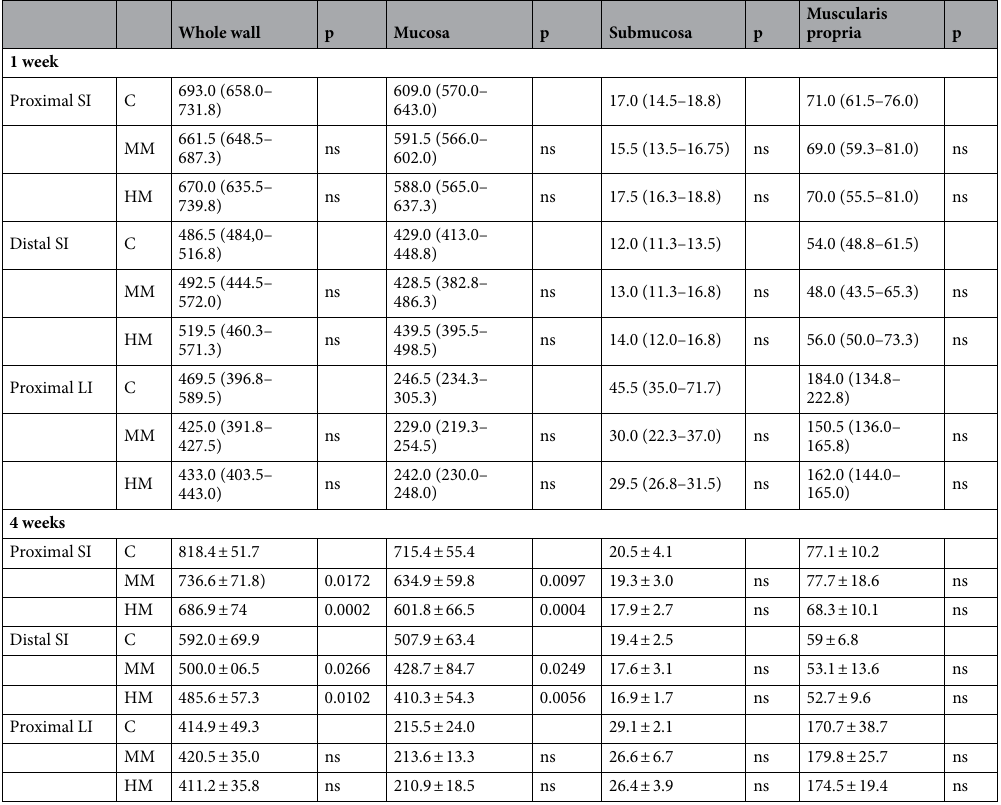
Table 2. Morphometric analysis of whole wall and layer thickness (µm) in proximal and distal small (SI) and proximal large intestine (LI) as estimated on Htx-E stained sections from rats fed control (C), medium Maillard (MM) or high Maillard (HM) containing diets for 1 or 4 weeks. Values from rats fed 1 week are expressed as median (interquartile range), n = 4, Kruskal–Wallis followed by Dunn´s multiple comparison test), Values from rats fed 4 weeks are expressed as mean ± SD, n = 10–11, one-way ANOVA followed by Dunnett´s multiple comparison test. P p value as compared to C, ns no significant differences compared to